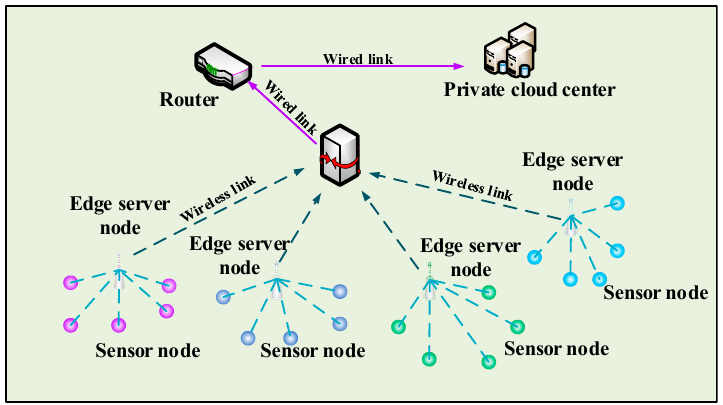
Figure 6. The network topology of the experimental platform.